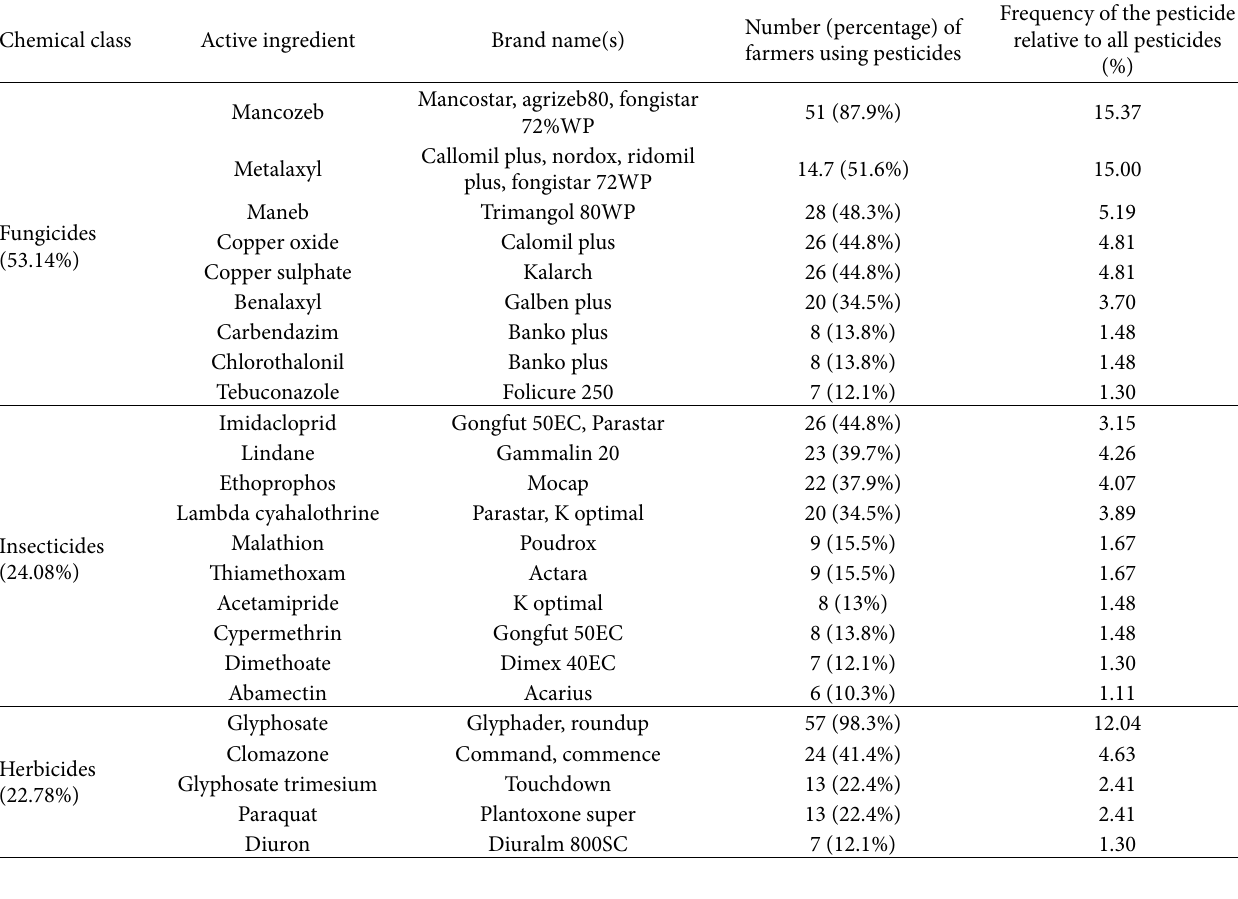
Table 3: Agropesticide active ingredients used by farmers.